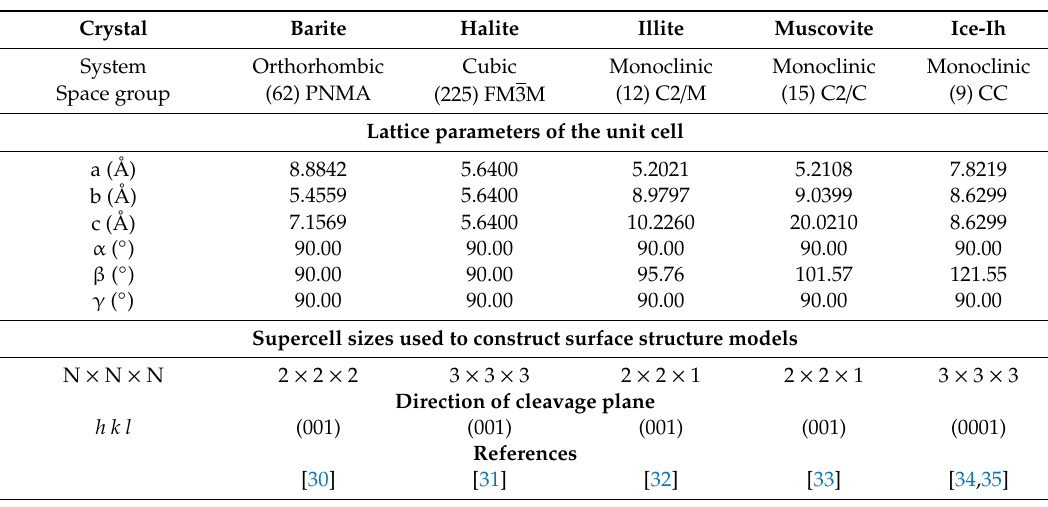
Figure 1. Cleaved surface structures of ( a ) barite, ( b ) halite, ( c ) illite, ( d ) muscovite, and ( e ) ice-Ih viewed from the side of the cleavage plane. The barite, halite, illite, and muscovite structures were cleaved in the direction of (001), and the ice-Ih structure was cleaved in the direction of (0001). Table 1. Structural information of the barite, halite, illite, muscovite, and ice-Ih crystals and their cleaved surface structures used in this study.